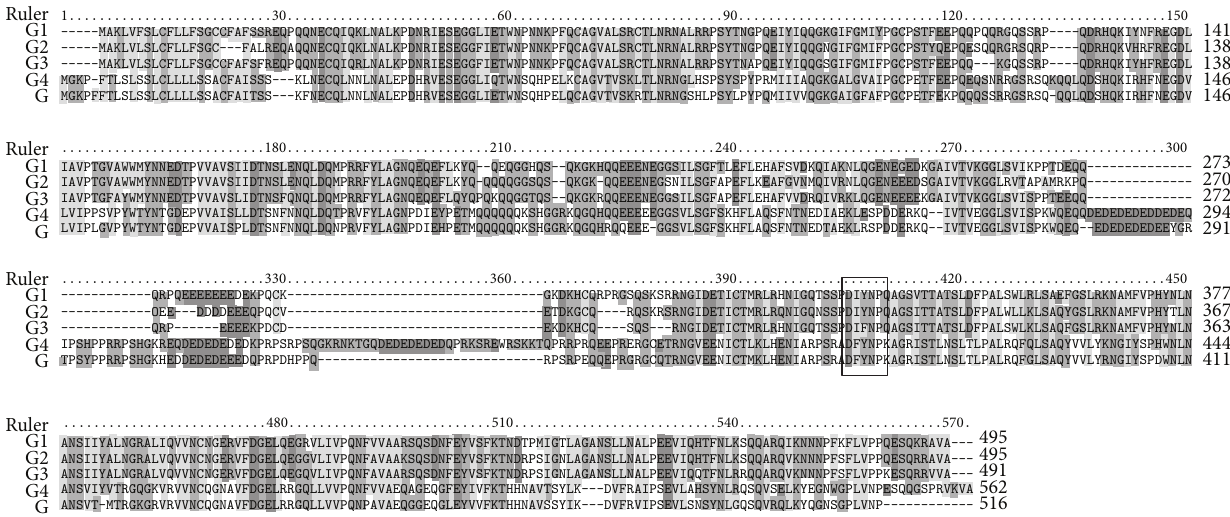
Figure 1: Alignment of glycinin precursor protein sequences. The sequence of soy glycinin was similar to that of Cblin peptide, indicated by the box. The sequences were retrieved from the UniProt database (http://www.uniprot.org/). G1, Glycinin G1; G2, Glycinin G2; G3, Glycinin G3; G, Glycinin G; G4, Glycinin G4.